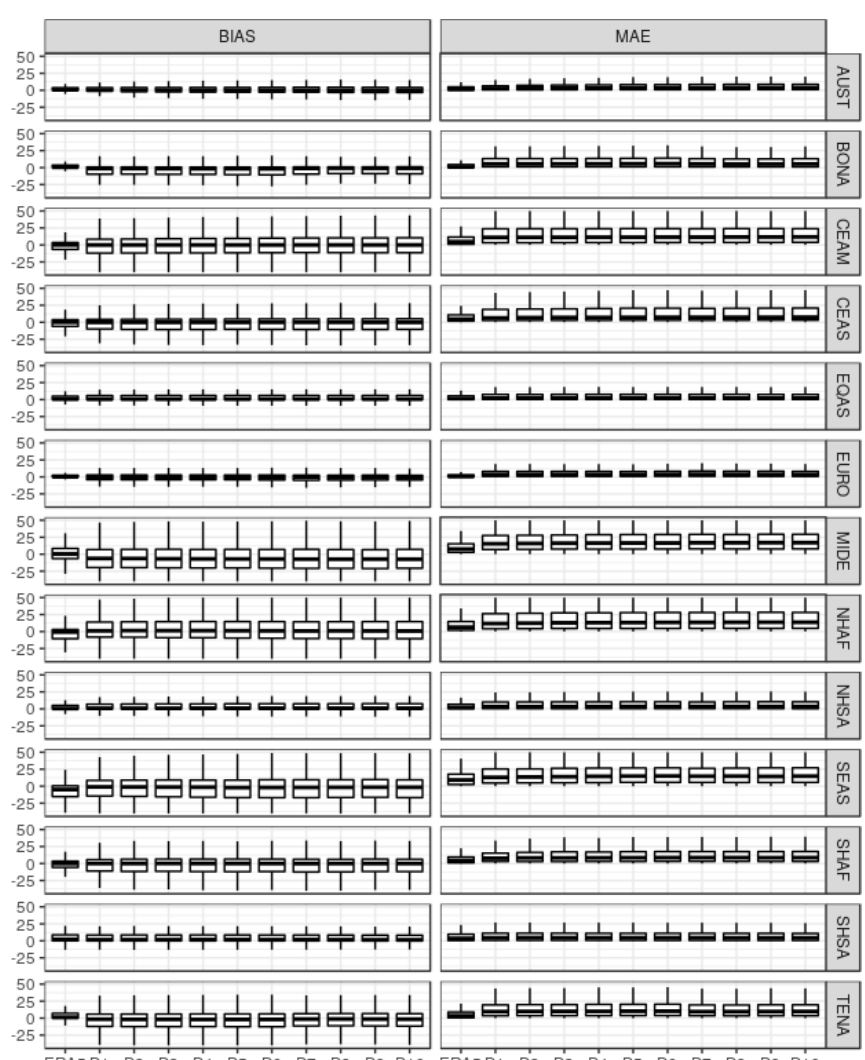
Figure 2. Comparison between modelled and observed FWI value across the GFED macro-regions. The FWI calculated using ECMWF high-resolution forecasts at different lead times is verified against ERA5 simulations. The box plots describe the distribution of values across the observation points for 1 year of simulations in 2017. Mean bias is plotted in the left panel and mean absolute error in the right panel. Table 1. Event summary table. Country Region Start date End date Main event Location